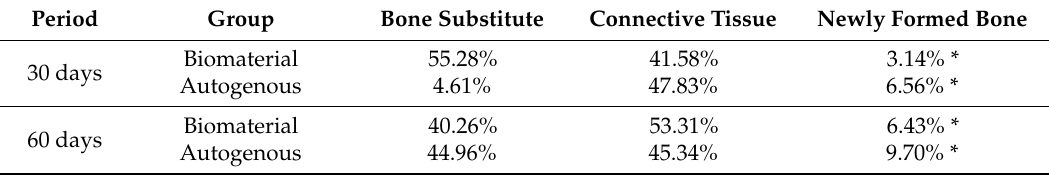
Analysis of the comparison between the biomaterial and autogenous bone at each experimental period.